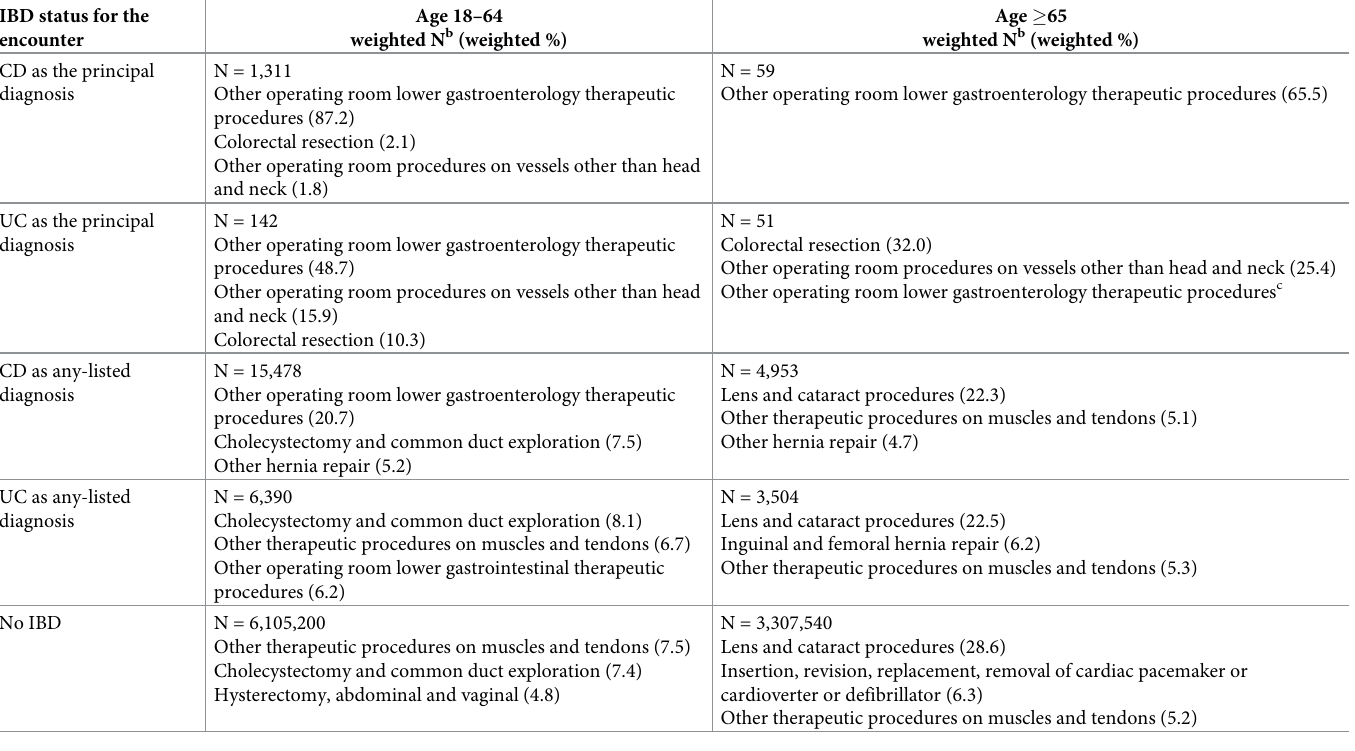
Table 2. Types of major in-scope a ambulatory surgeries with the top high-procedure volume by order, by age groups and inflammatory bowel disease status, 2017. IBD status for the